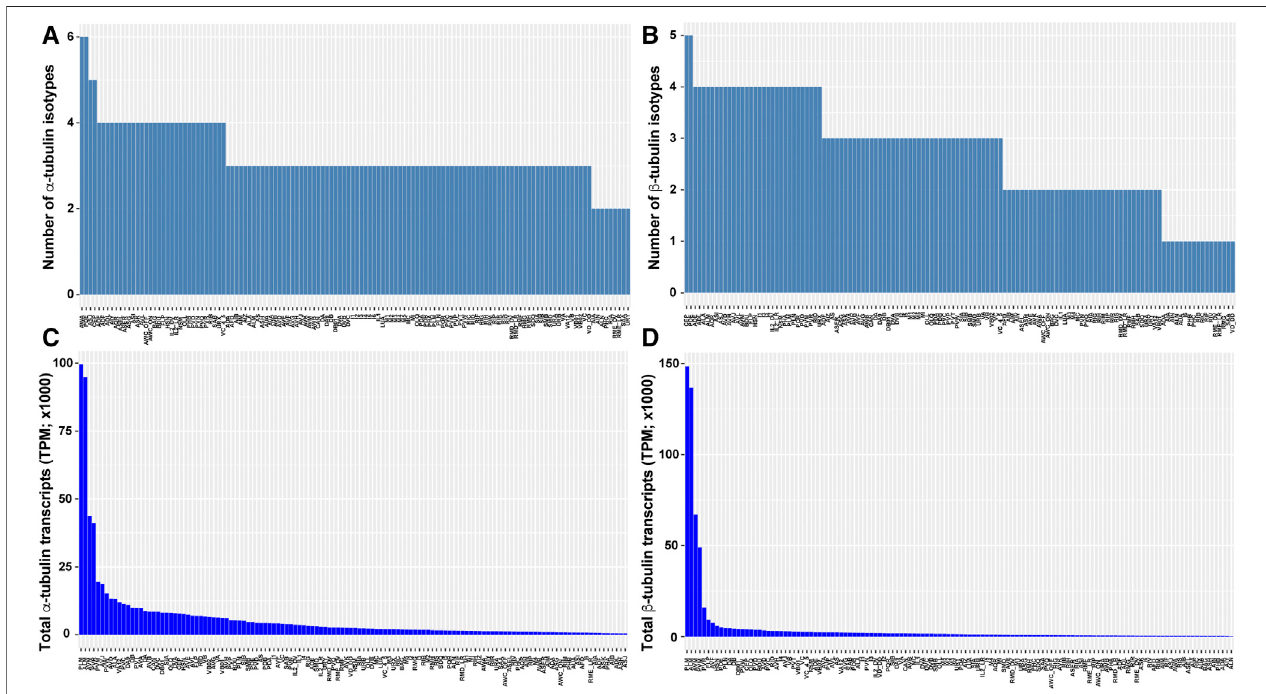
FIGURE3| Tubulinisotypenumbersandtotaltubulintranscriptsamongdifferentneurontypesin C.elegans .Thenumberoftubulinisotypesexpressed(TPM > 0)in each neuron type were counted for α -tubulin (A) and β -tubulin (B) isotypes from the scRNA-seq data. The total number of α -tubulin (C) and β -tubulin (D) transcripts in each neuron type were calculated by summing the TPM of each